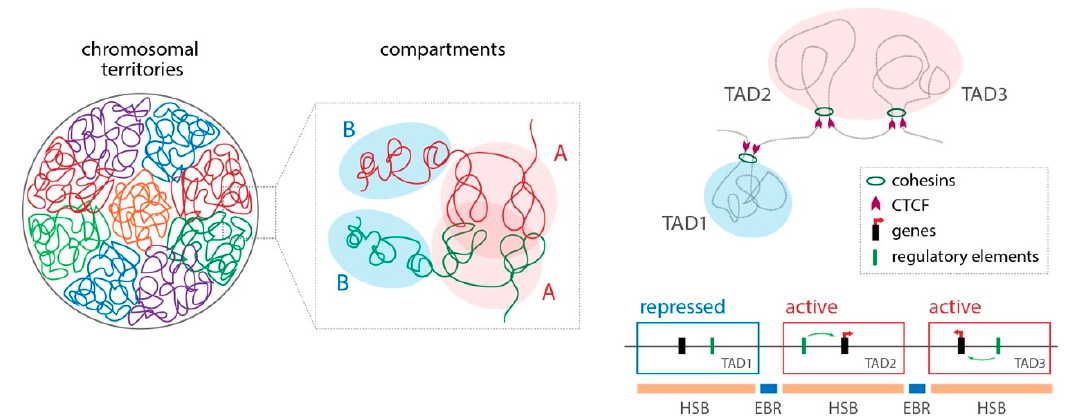
Figure 3. The integrative breakage model, a multilayer framework for the study of genome evolution that takes into account the high-level structural organisation of genomes and the functional constraints that accompany genome reshu ffl ing [64]. Genomes are compartmentalised into di ff erent levels of organisation that include: (i) chromosomal territories, (ii) ‘open’ (termed ‘A’) / ’closed’ (termed ‘B’) compartments inside chromosomal territories, (iii) topologically associated domains (TADs) and (iv) looping interactions. TADs, which are delimited by insulating factors such as CTCF and cohesins, harbour looping topologies that permit long-range interactions between target genes and their distal enhancers, thus providing ‘regulatory neighbourhoods’ within homologous syntenic blocks (HSBs). In this context, the integrative breakage model proposes that genomic regions involved in evolutionary reshu ffl ing (evolutionary breakpoint regions, EBRs) which will likely be fixed within populations are (i) those that contain open chromatin DNA configurations and epigenetic features that could promote DNA accessibility and therefore genomic instability, and (ii) that do not disturb essential genes and / or gene expression.